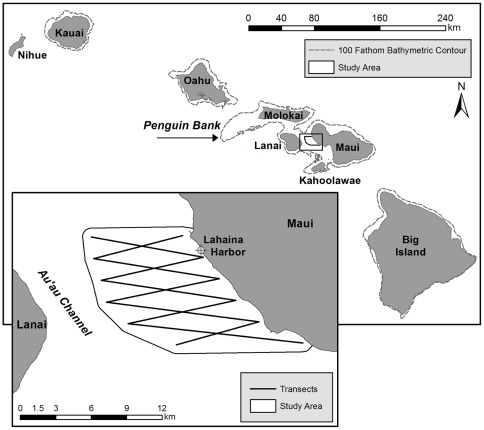
Map of the Hawaiian Islands, Au'au Channel and the study area.Within the study area, zigzag transect lines were constructed between waypoints set at 1 minute intervals. Inner waypoints were set at 0.25 km from the shoreline and outer way points set at the deepest or mid-point of the channel, whichever lay furthest offshore. The final perimeter of the study area extended from the shoreline to 750 m beyond the outer waypoints.